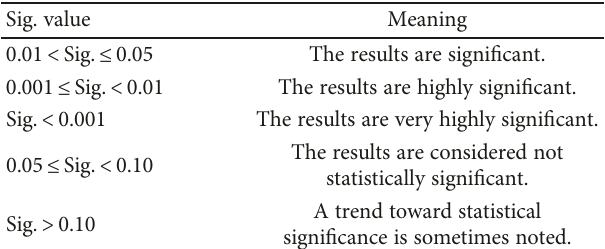
Table 6: The interpretation of the Sig. value [23]. Sig. value